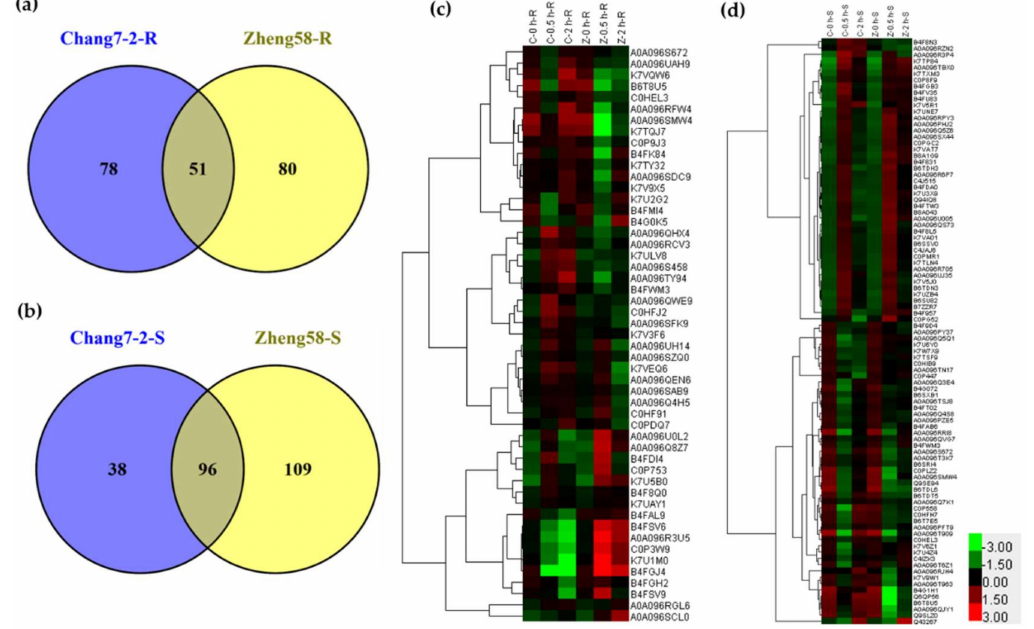
Figure 4. Di ff erently regulated phosphoproteins (DRPPs) in salt-treated Chang7-2 and Zheng58 in roots ( a ) and shoots ( b ); clustering analysis of DRPPs detected in both Chang7-2 and Zheng58 seedlings (( c ), roots and ( d ),